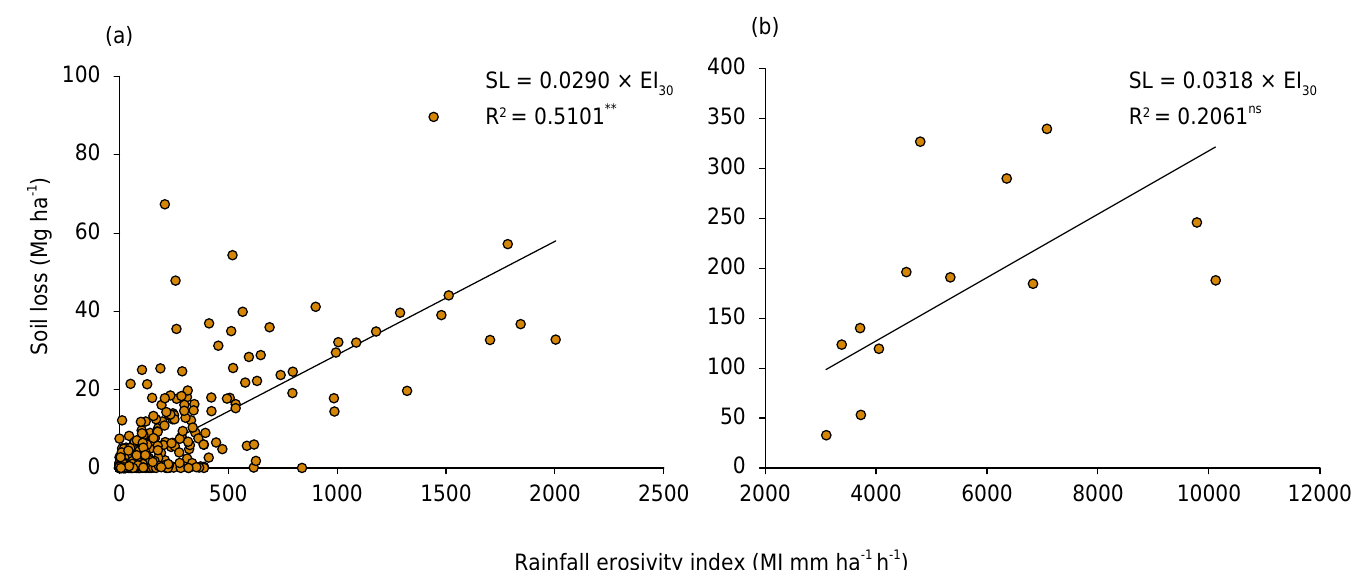
Figure 1. Relation of the erosivity index (EI 30 ) to the respective soil loss (a) with all the collections of soil losses with accumulated erosive and non-erosive rains and (b) with the mean annual soil losses and mean annual erosivities over the 13 years of carrying out the experiment, in Eldorado do Sul, RS, Brazil. ns : non-significant; ** : significant at the level of 1